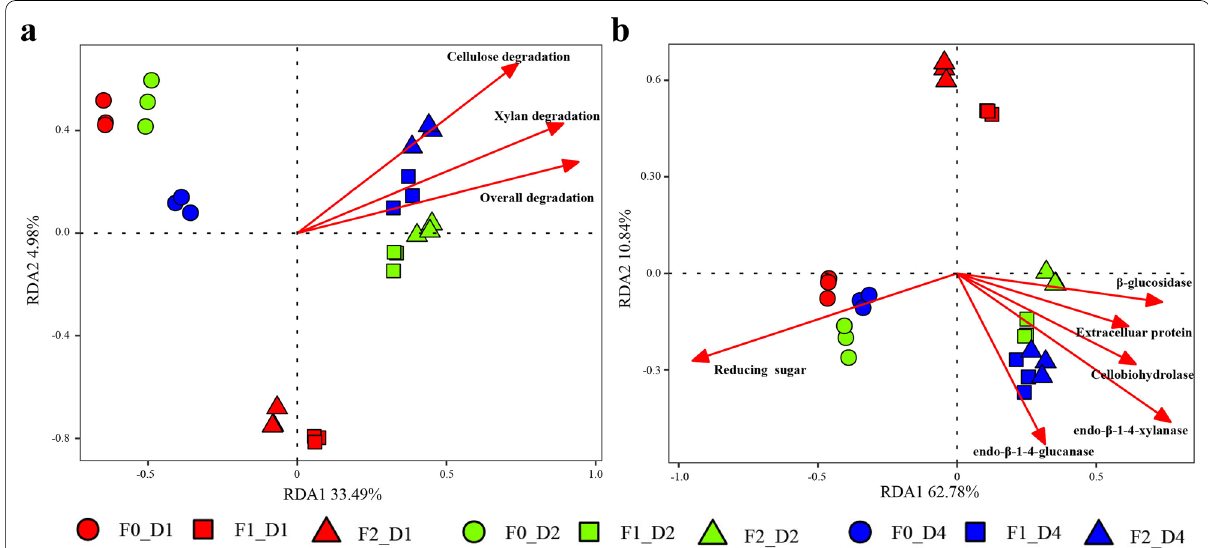
Fig. 6 Redundancy analysis of the relationship between degradation activities and bacterial community composition. A The relationship between degradation rates of carbon source and community composition. B The relationship between environmental parameters and community